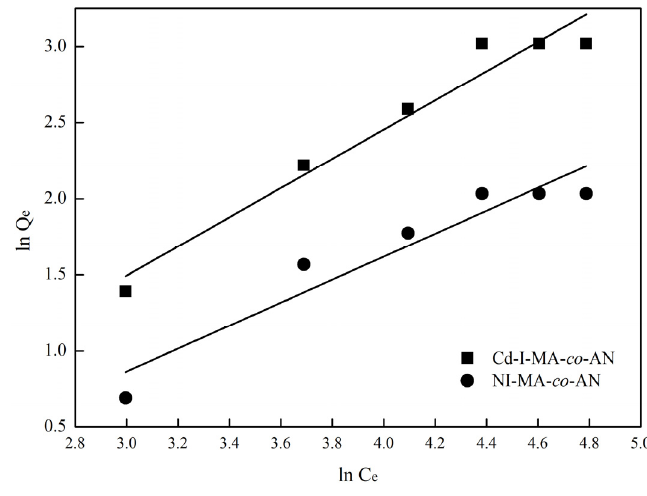
Figure 9. Freundlich isotherm model. Table 1. Langmuir isotherm constants for adsorption of Cd-I-MA- co -AN and NI-MA- co -AN.